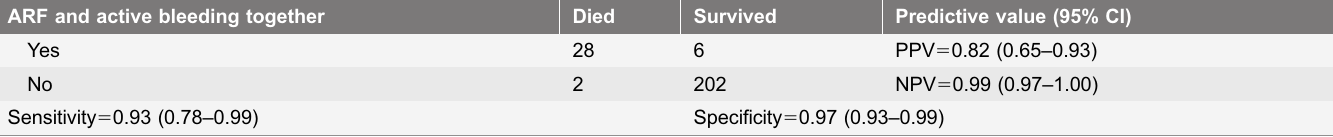
Table 3. Sensitivity, specificity, NPV and PPV of combined ARF and active bleeding in prediction of fatal DVI. ARF and active bleeding